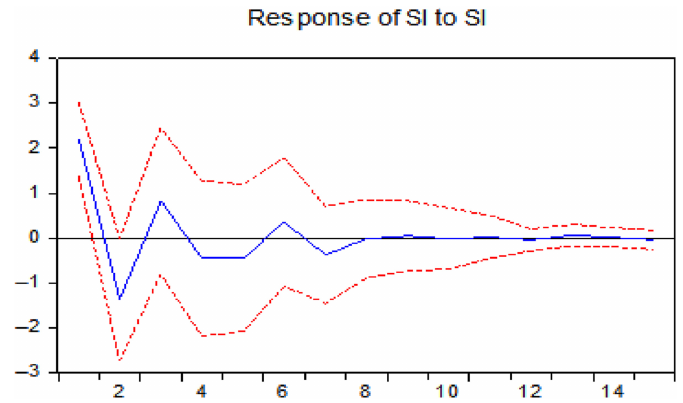
Figure 7. Response to China ’ s marine economy ’ s autonomous shock